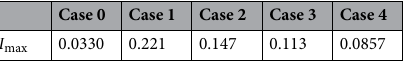
Table 3. Effective healthcare capacity I max